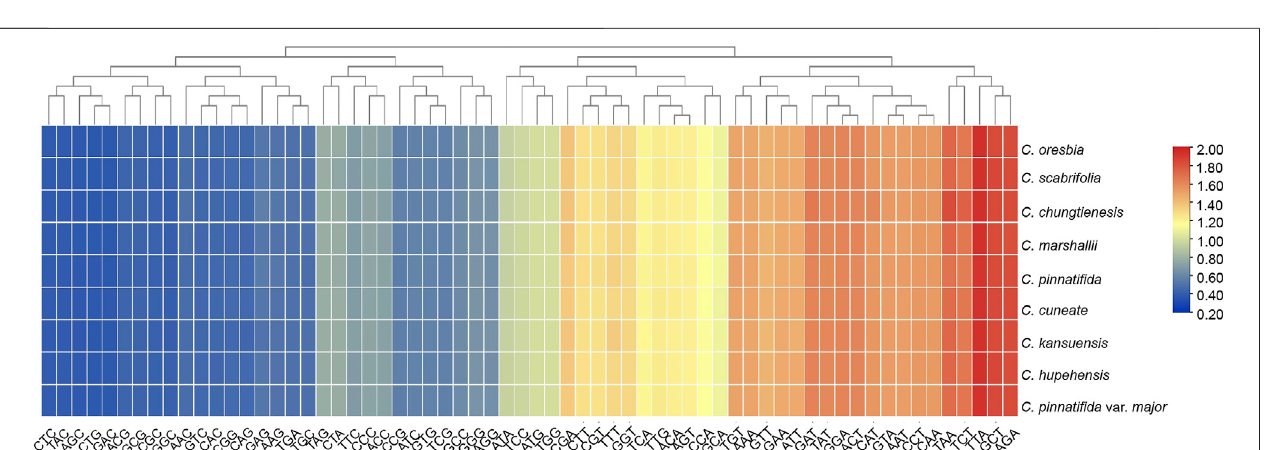
Frontiers in Genetics |